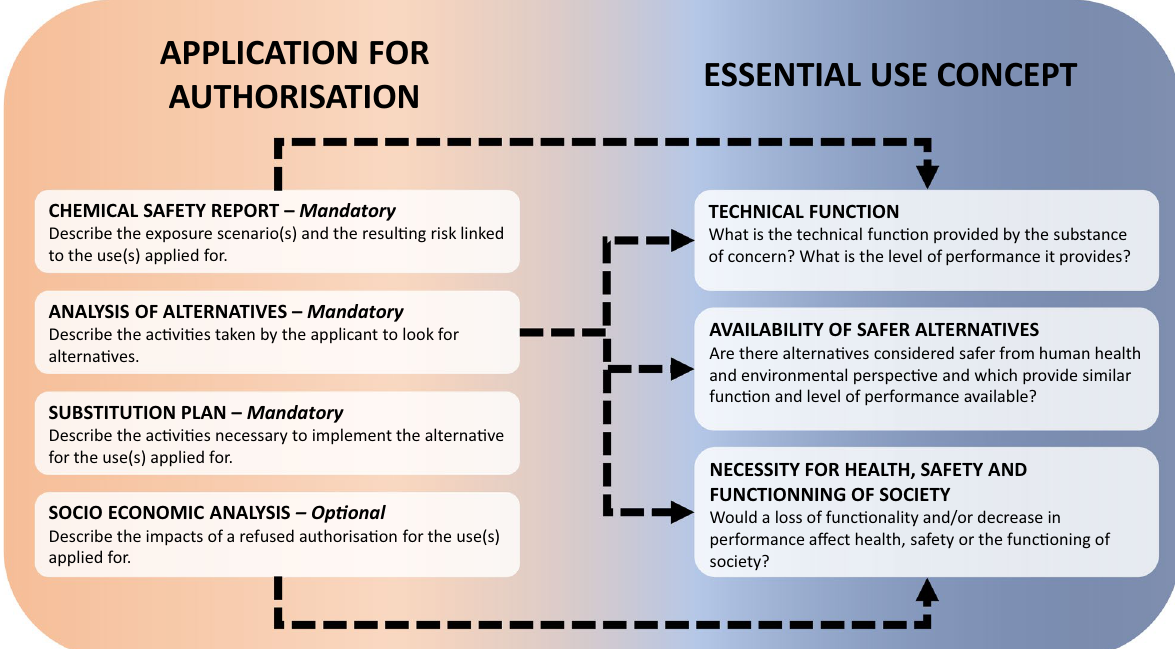
Fig. 1 Schematic showing how the information required in an application for authorisation can be used in an essentiality assessment of the use applied